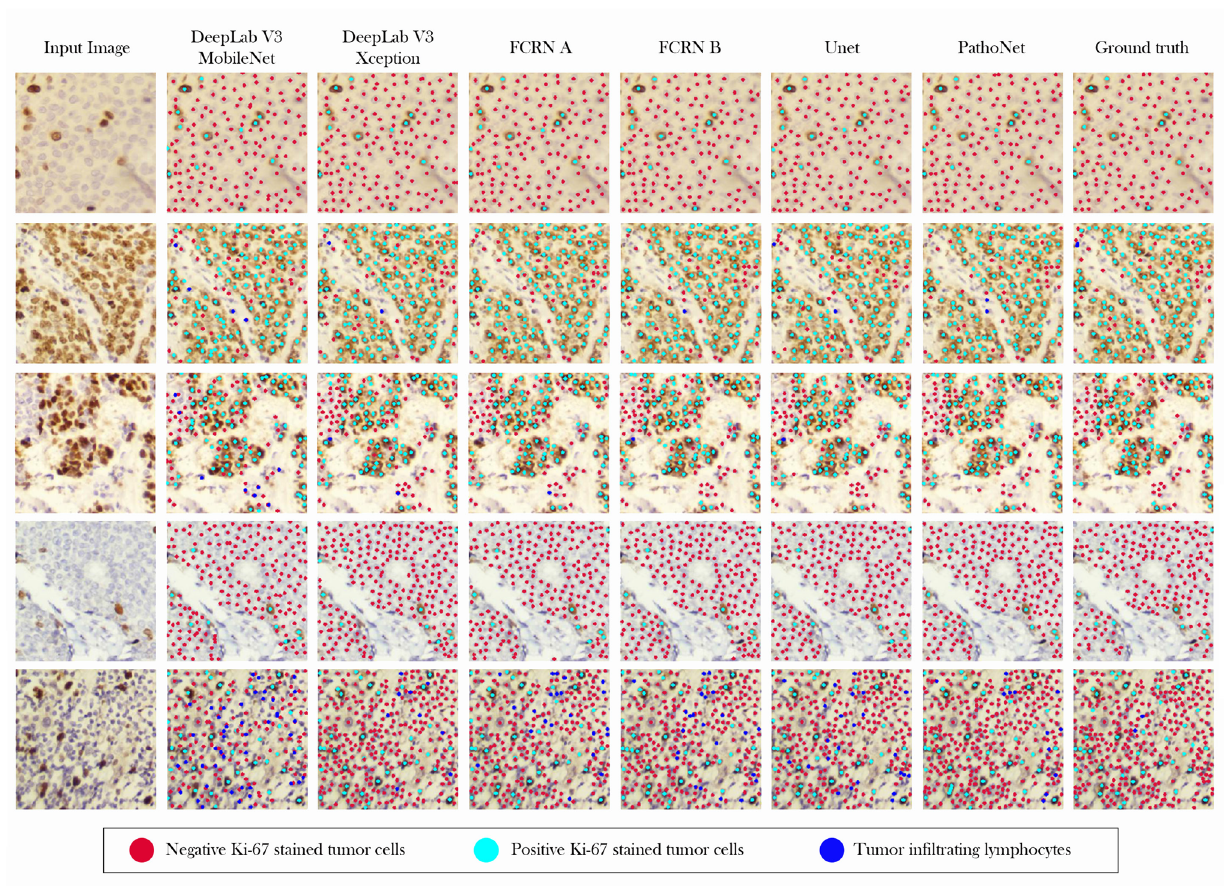
Figure 9. Qualitative results. Samples from SHIDC-B-Ki-67 test set. Points in red show negative Ki-67 stained tumor cells. Blue points depict positive Ki-67 stained tumor cells and dots with cyan color, show tumor infiltrating lymphocytes. In this image, ground truth column is expert annotation.